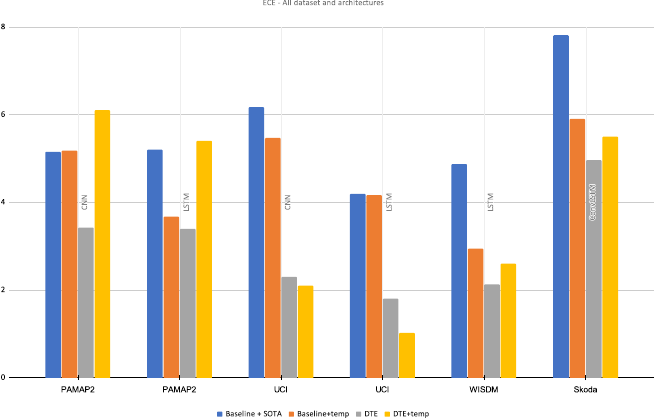
Figure 7. Comparison of ECE (along y -axis) between baseline, baseline + temperature-scaled, DTE, DTE + temperature-scaled models.